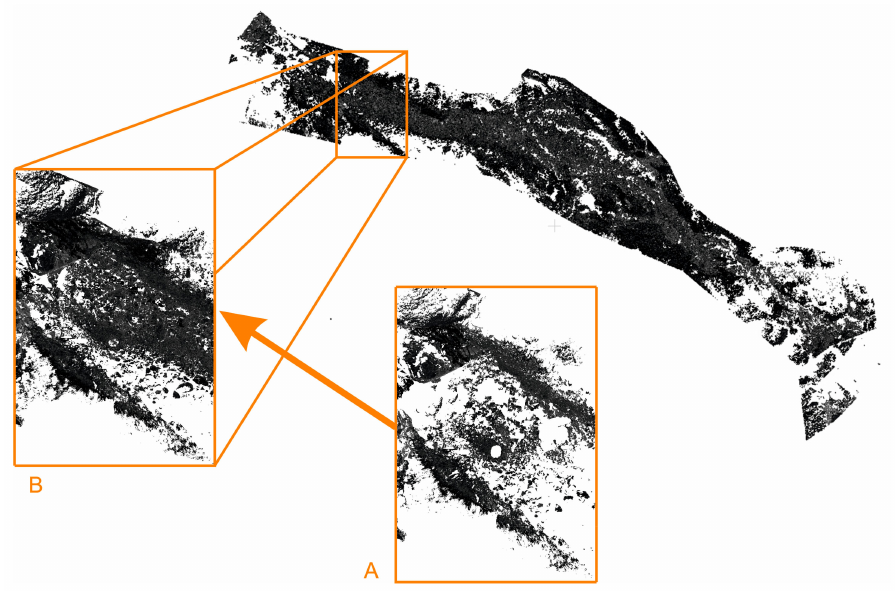
Figure 9. 3D scanning data after registration—whole area of interest. ( A ) Detail of data acquired from one standpoint, and ( B ) detail of complete data.